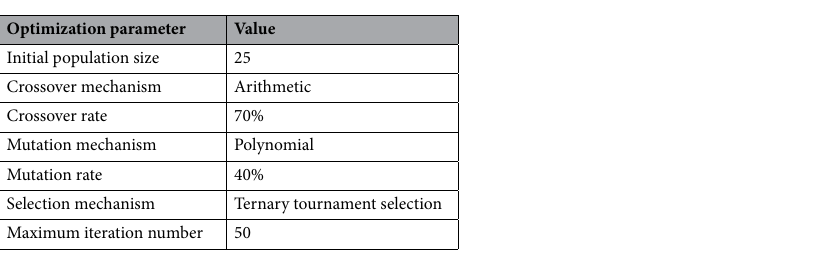
Table 1. The values of parameters used for multi-objective optimization by G.A.